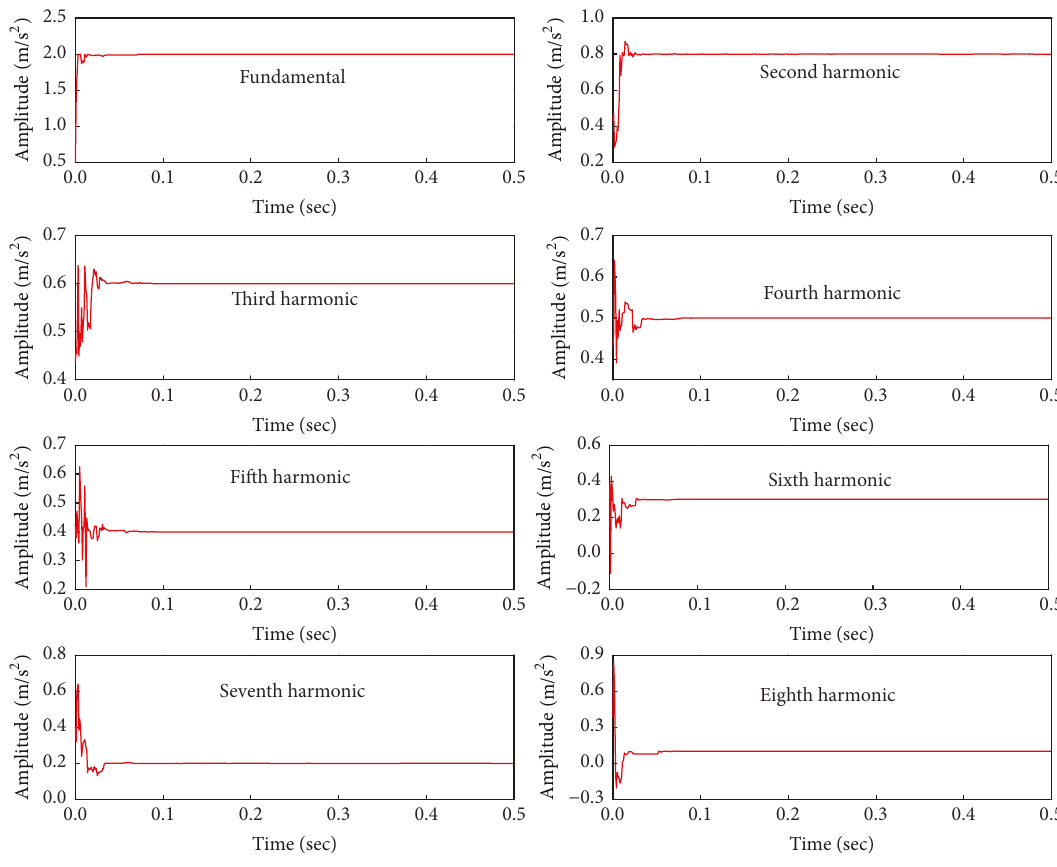
Figure 7: Estimated amplitude of